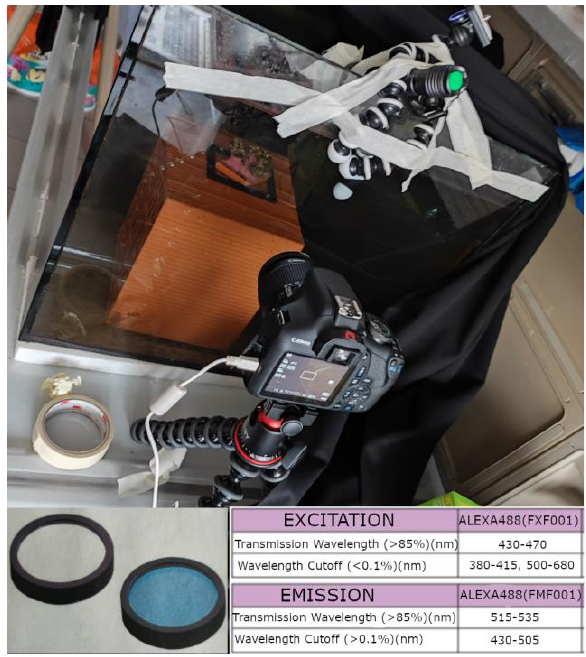
Figure 2 . Fluorimetry set-up: camera over a tripod, light-source (top centre), used filters (emission-left and excitation-right) and their specs